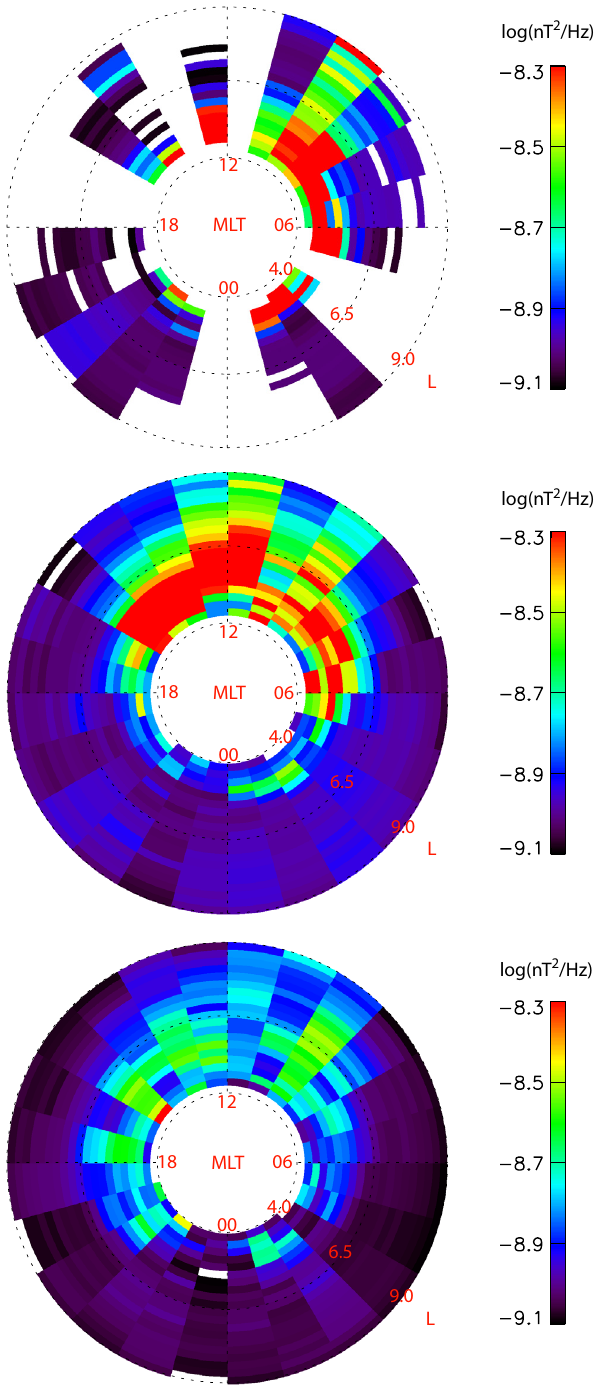
Fig. 7. Distributions of the spectral density in the frequency range 0 . 1 ≤ f/f ce < 0 . 5 (lower-band chorus) for different K p lev- els. Top, central, and bottom panel corresponds, respectively, to high ( K p ≥ 5o), moderate (3 o ≤ K p < 5o), and low ( K p < 3o) levels of magnetospheric